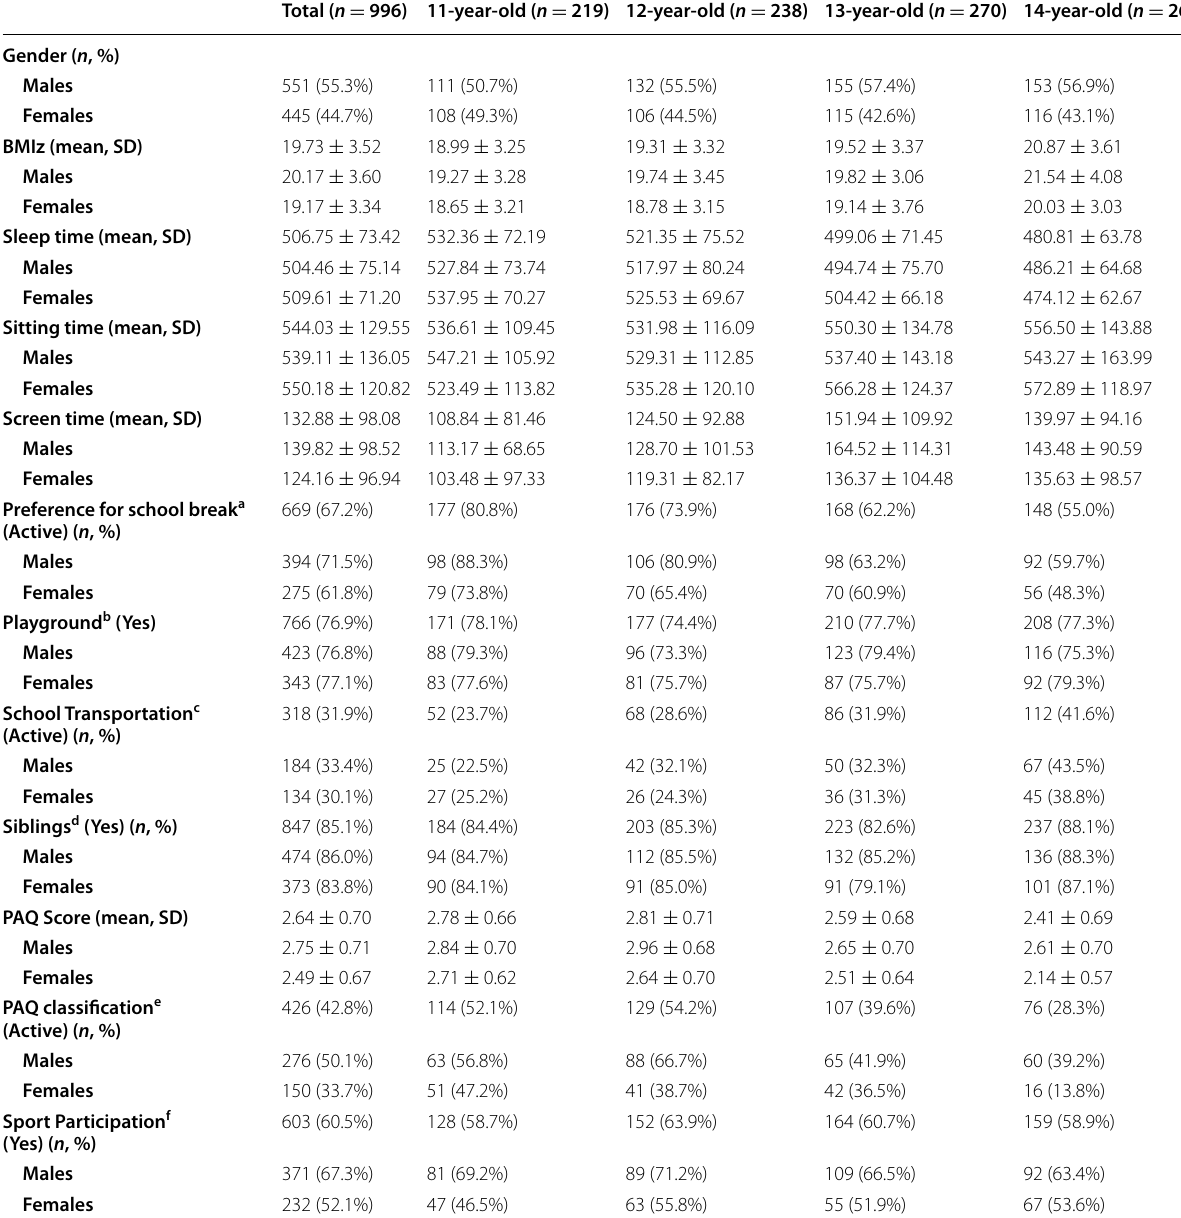
Table 1 Characteristics of study